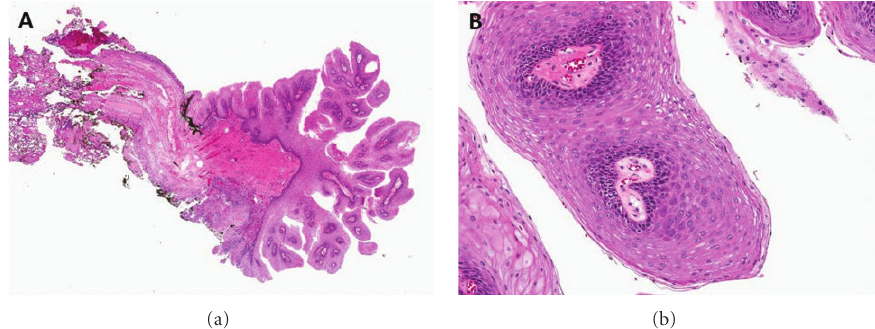
Figure 2: Low power (10 × ) and high power (50 × ) hematoxylin and eosin stained sections from the uvula lesion. (a) The low power view demonstrates a papillary lesion consisting of multiple squamous lined papillary fronds containing fibrovascular cores. (b) At higher power the squamous cells show bland histological features. These findings are characteristic of a squamous